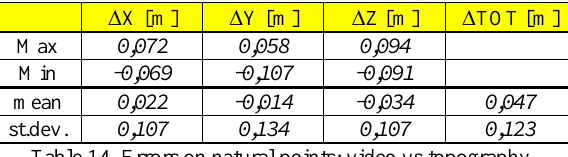
Table 14. Errors on natural points: video vs topography.